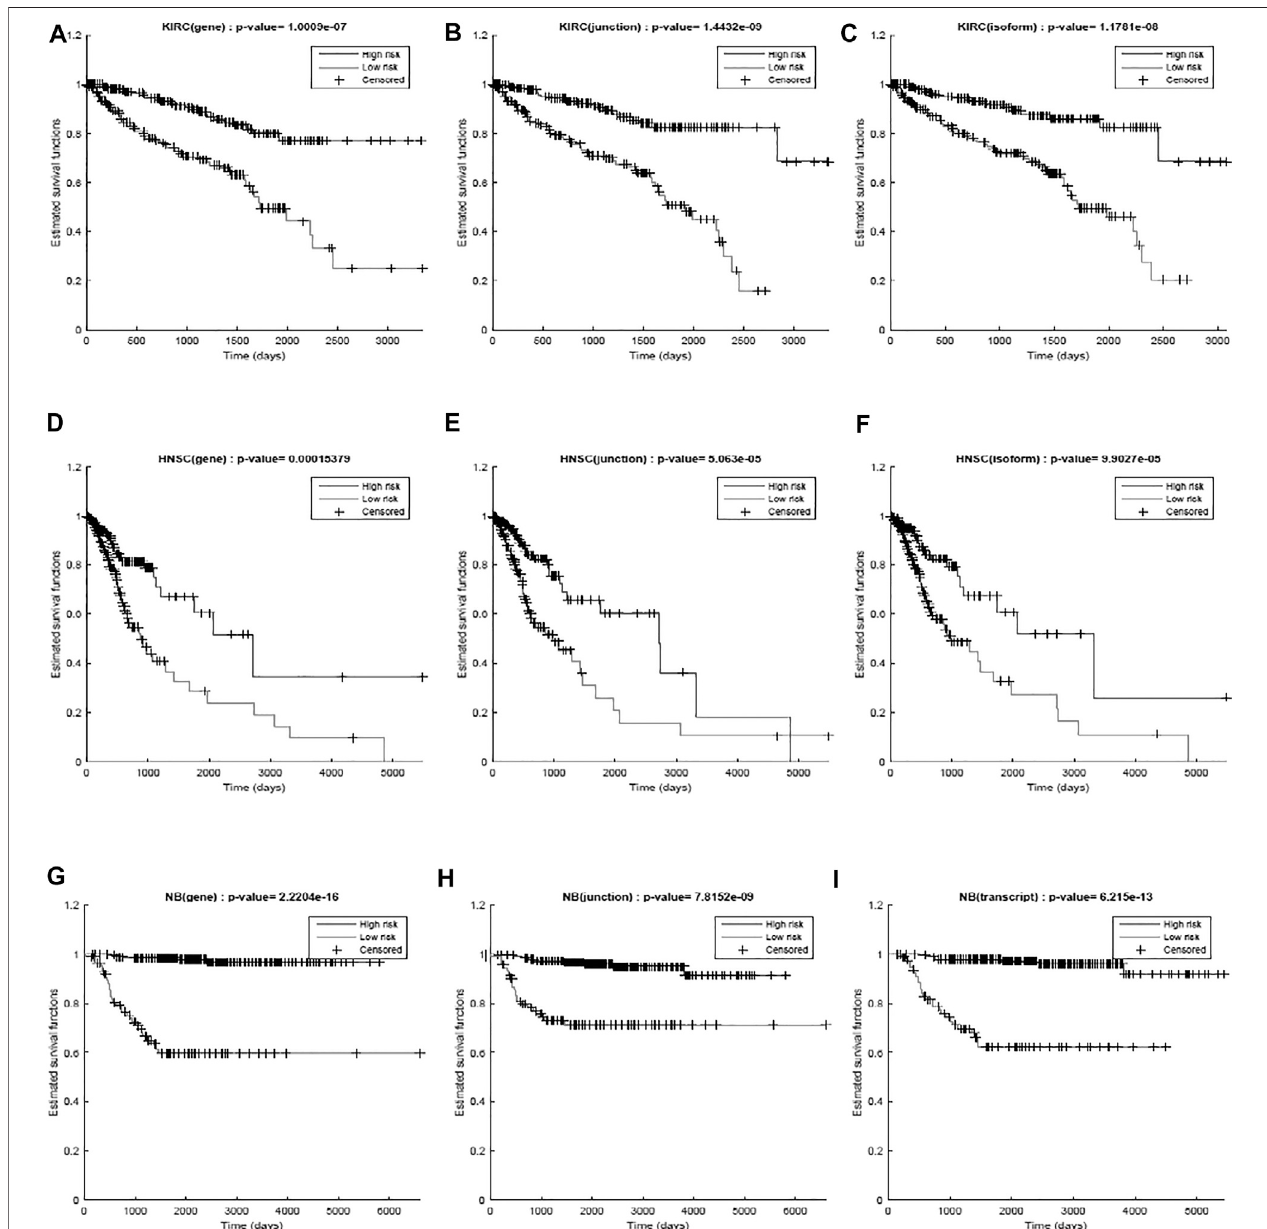
FIGURE 3 | Kaplan – Meier curves and the log-rank p -values for the predictions made by the proposed work for different diseases (KIRC, HNSC, and NB) per differentmodalities(gene,junction,andisoform). (A) RNA-seqgene, (B) RNA-seqjunction,and (C) RNA-seqisoformforkidneycancer; (D) RNA-seqgene, (E) RNA-seq junction, and (F) RNA-seq isoformforhead and neckcancer; (G) RNA-seq gene, (H) RNA-seq junction, and (I) RNA-seq isoformforneuroblastoma. The curves showa clear separation between the two predicted groups.